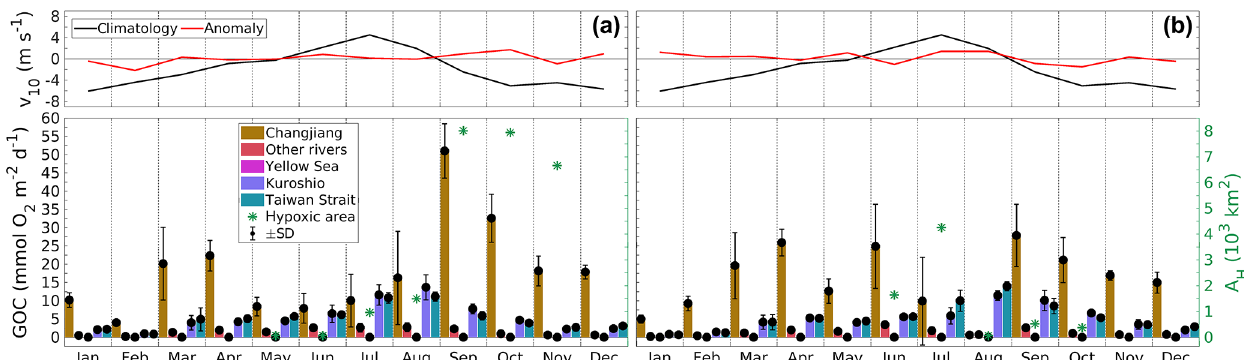
Figure 5. Monthly time series of source-specific contributions to GOC and total hypoxic area ( A H ) in the southern region (see Fig. 1) in (a) 2008 (year of largest A H ) and (b) 2013 (smallest A H ), and anomaly of northward wind speed 10m above sea level ( v 10 ) relative to 2008–2013 (“climatology”) averaged over the ECS (25–33 ◦ N, 119–125 ◦ E). Same legend and axes for both